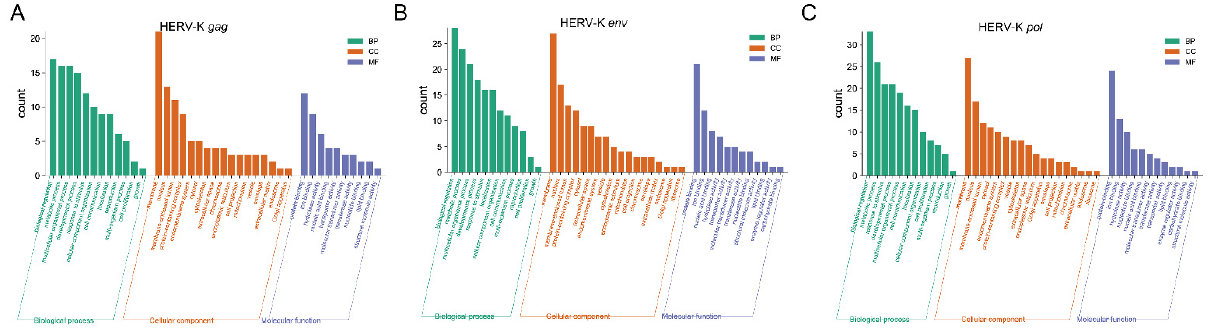
Figure 4. GO functional classification of differentially expressed genes (DEGs) among different samples. The distributions of highly expressed ( A ) HERV-K gag , ( B ) HERV-K env and ( C ) HERV-K pol are summarized in three main categories: biological process (BP), molecular function (MF), and cellular component (CC).